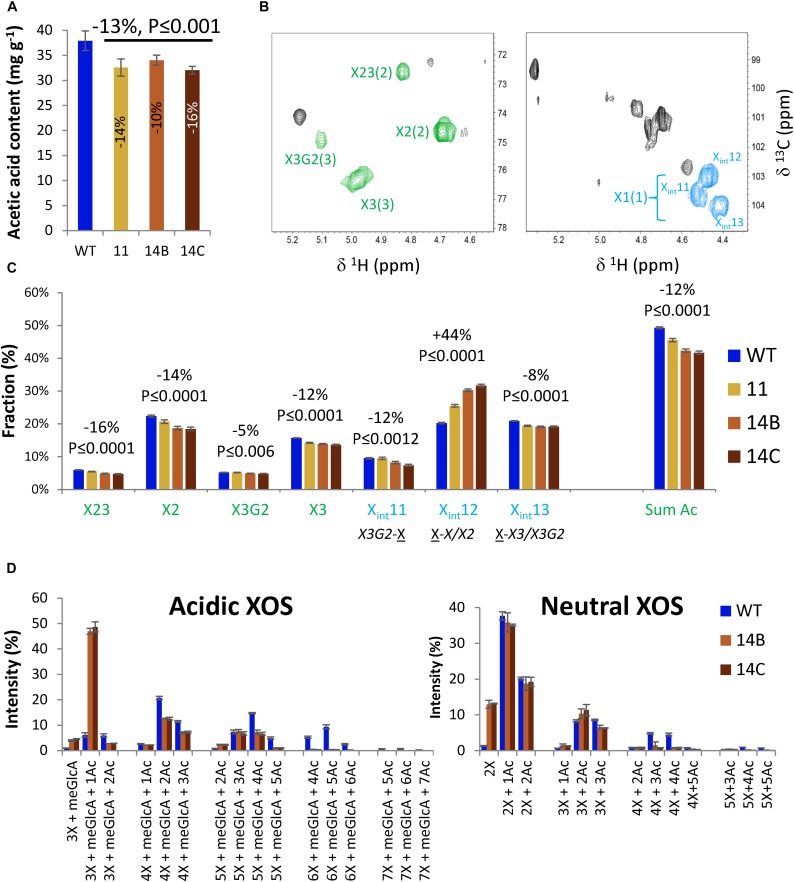
Effects of WP:CE5 expression (lines 11, 14B, and 14C) on xylan acetylation in aspen wood. (A) Cell wall acetyl content determined by acetic acid release. (B) 2D qHSQC NMR spectra of extracted xylan showing signals from acetylated (green) and non-acetylated (blue) Xylp units in xylan, which were used for quantification in (C). X23-diacetylated Xylp; X2-Xylp monoacetylated at position 2; X3G2-Xylp acetylated at position 3 and glucuronosylated at position 2; numbers in parenthesis correspond to carbon number in Xylp; Xint – different internal Xylp signals as assigned by Grantham et al. (2017). (D) OLIMP analysis of acidic and neutral xylo-oligosaccharides (XOS) released by endoxylanase AaGH10. Data are means ± SE, N = 2 or more biological × 3 technical replicates for (A), 2 or more biological × 2 technical replicates for (C), and 2 biological replicates for (D). P-values in (A,C) correspond to post-ANOVA contrast analysis comparing all transgenic lines to WT.